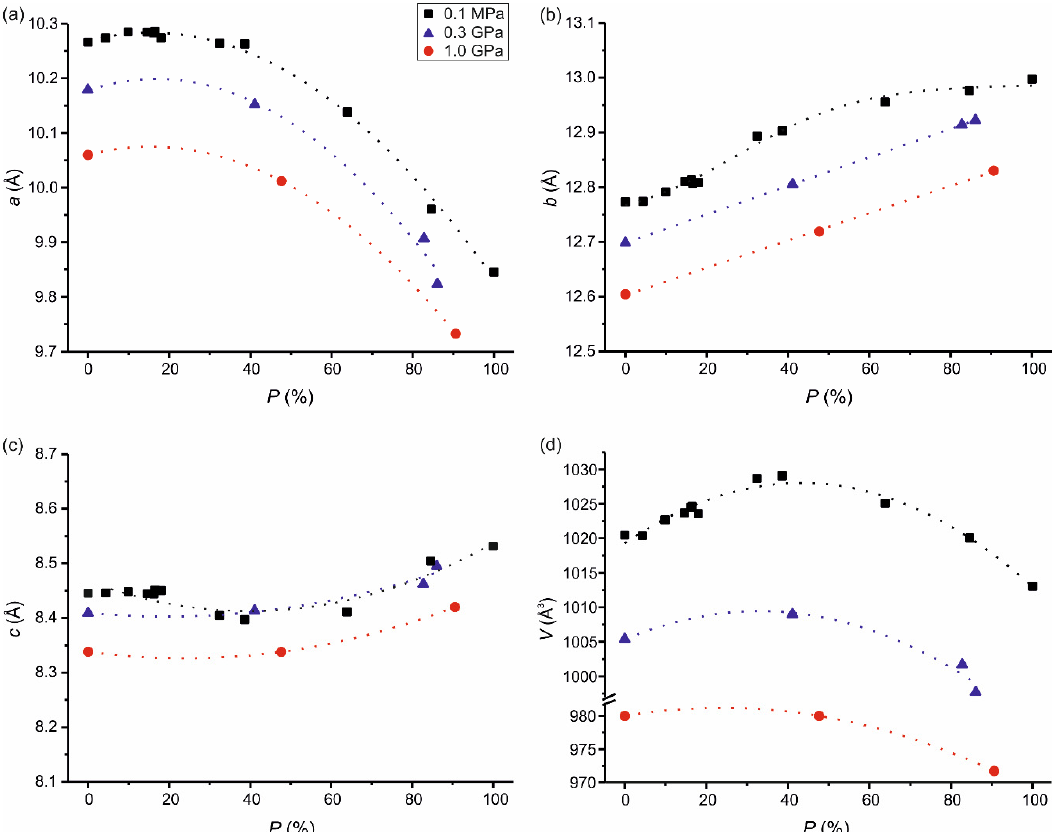
Figure 1. The variations in ( a – c ) the unit cell parameters and ( d ) the cell volume for ( 1 ) with the reaction progress ( P —the content of the product in the crystal) at 0.1 MPa, 0.3 GPa and 1.0 GPa. For a better comparison the range of the axes for plots ( a – c ) was set to be the same. The data for 0.1 MPa were taken from [5].